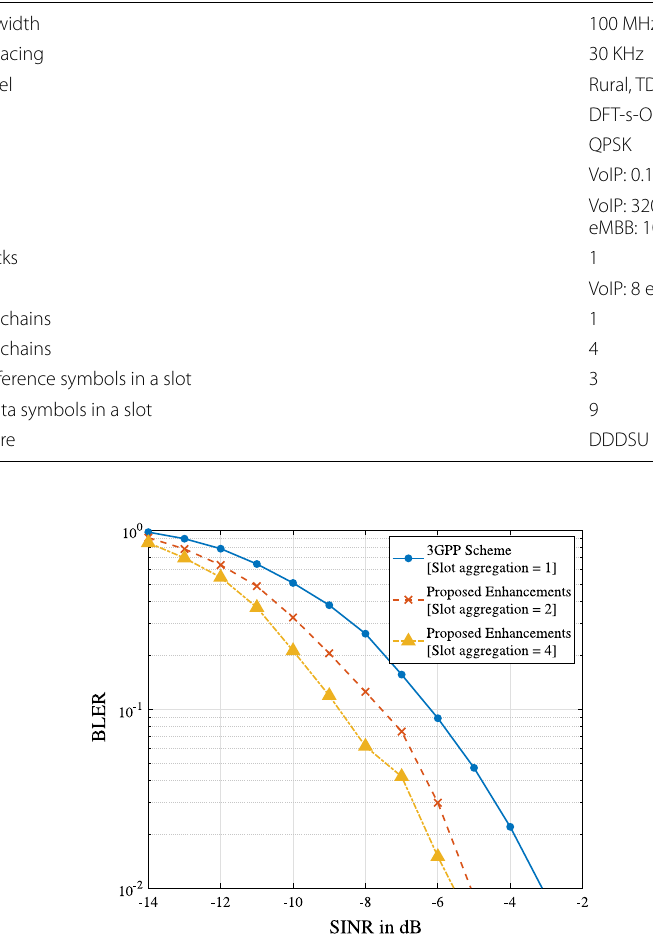
Fig. 15 Link-level evaluation of proposed transport-block scaling scheme